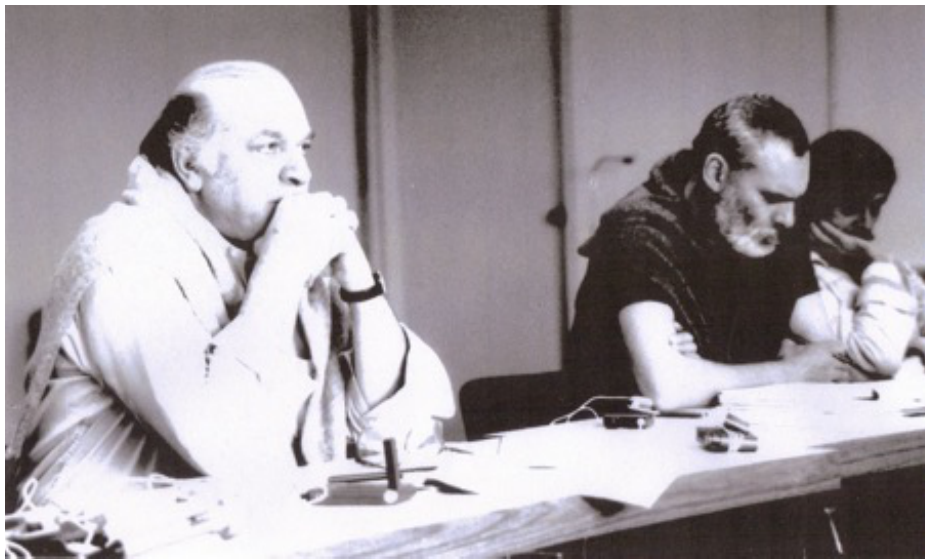
Figure 2: Stanley Cavell, Jeffrey Steele, Luis Castro-Leiva, Caracas Workshop, 14th December 1984. (Photo: Gloria Carnevali. Reproduced with